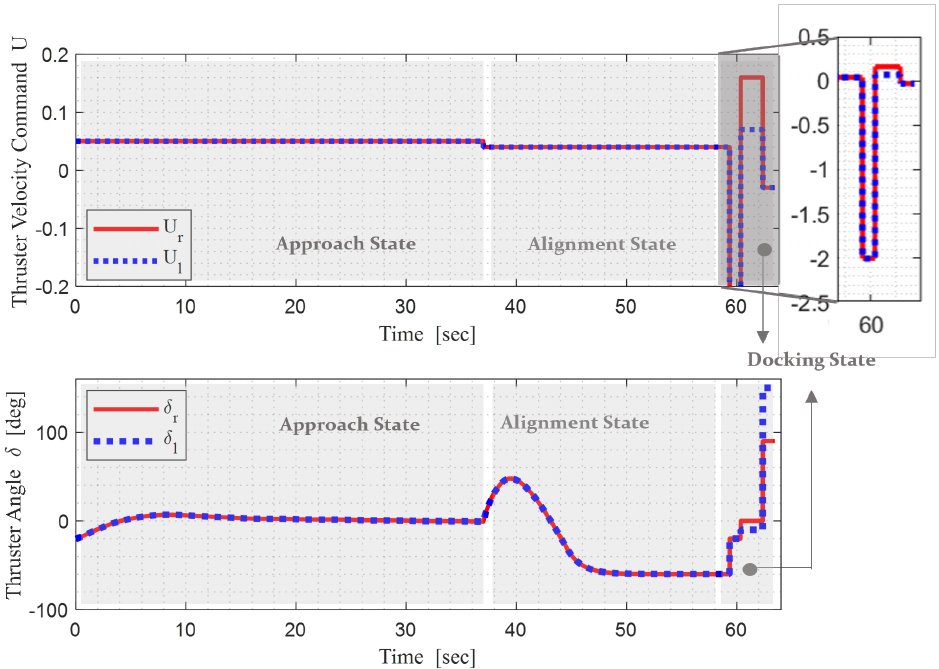
Figure 13. Thruster command in parallel-type berthing simulation using the MRAC controller expressed by state